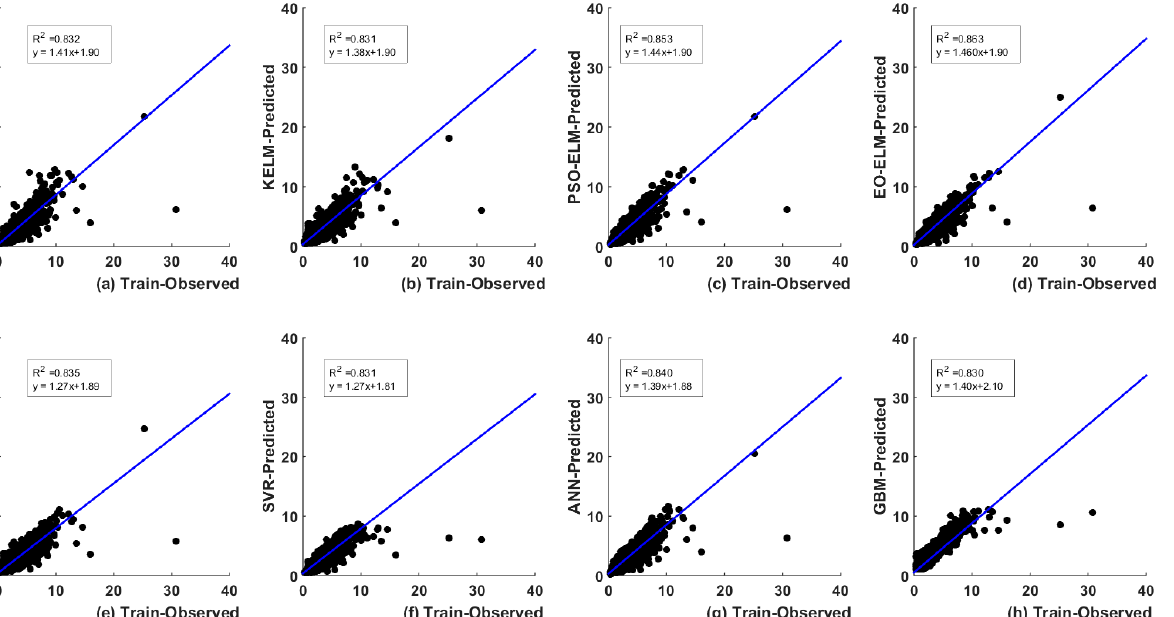
Figure 8. Prediction capability of the eight models in test case ( a ) ELM, ( b ) KELM, ( c ) PSO-ELM, ( d ) EO-ELM, ( e ) DNN, ( f ) SVR, ( g ) ANN, and ( h ) GBM for the catchment Fal at Tregony. Figure 9 shows the precise prediction line for EO-ELM (Figure 9a) against observed values in the test case compared to PSO-ELM (Figure 9b). The overfitting lines of peak discharge values are higher and underfitting lines of low discharge values for PSO-ELM are lower compared to EO-ELM (Figure 9). The Taylor plot (Figure 10a,b) confirms the better prediction performance of EO-ELM in terms of statistical comparison of all the models.